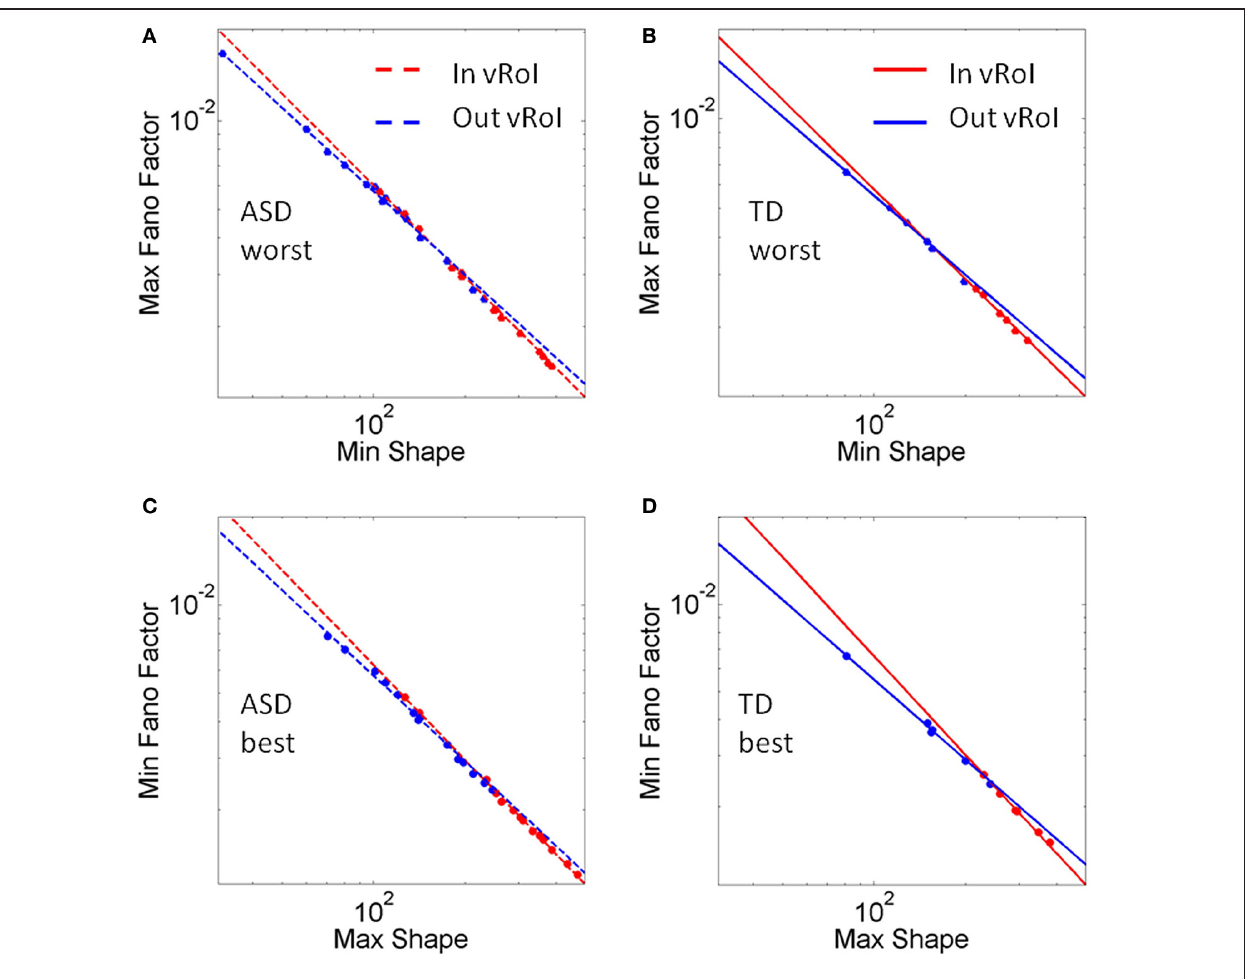
FIGURE 11 | Lack of differentiation between randomly searching motions and goal-directed motions in ASD. (A,B) Worst performance of ASD and TD participants given by their highest Fano Factor values; lowest shape parameter values and poorest distinction between IN and OUT vRoI